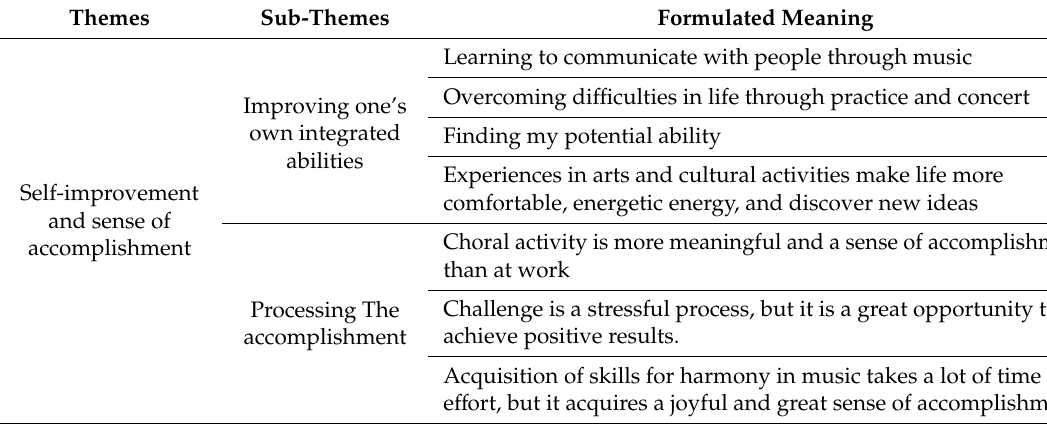
Table 2. Classification of